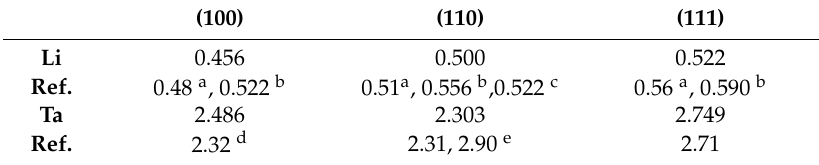
Table 2. The calculated surface energies of BCC-Li and BCC-Ta (in J / m 2